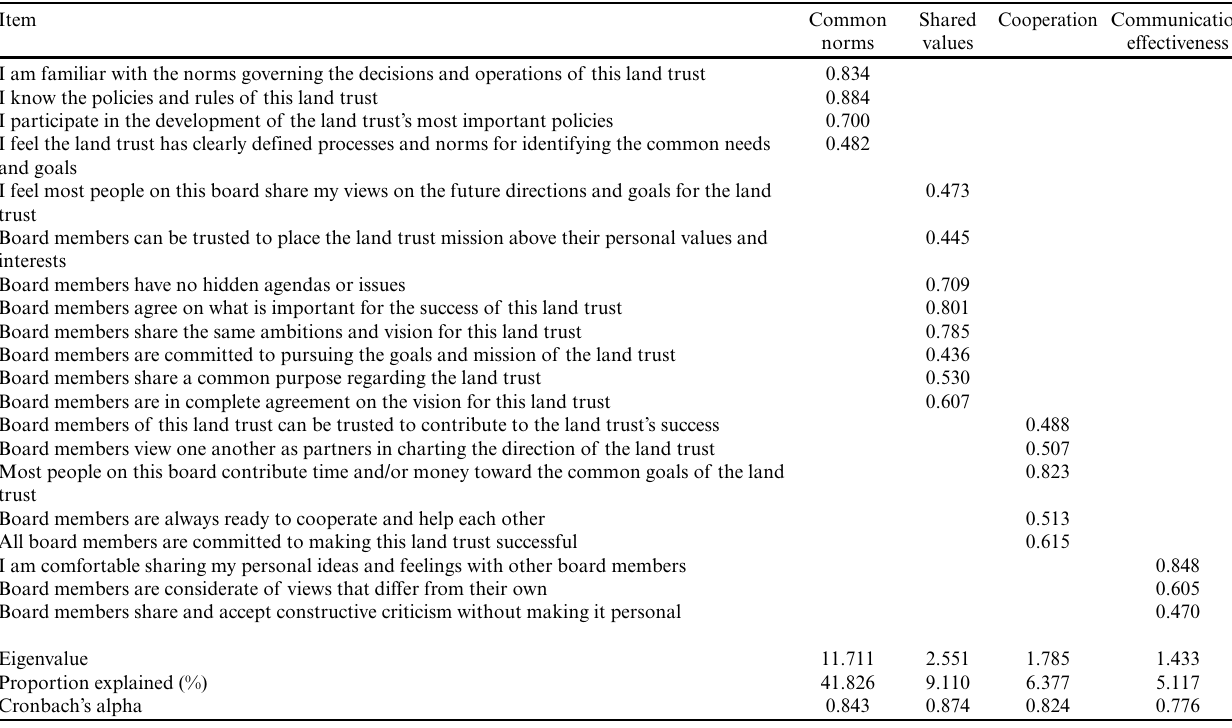
Table 1. Factor loadings of cognitive social capital items on the four principle axes factors (n = 79). Loading values are from the pattern matrix and show the relationship between each observed variable and each factor. Principal Axis Factor Extraction with Promax Rotation (power = 4), loadings ≥ 0.4 used in the interpretation of each factor.